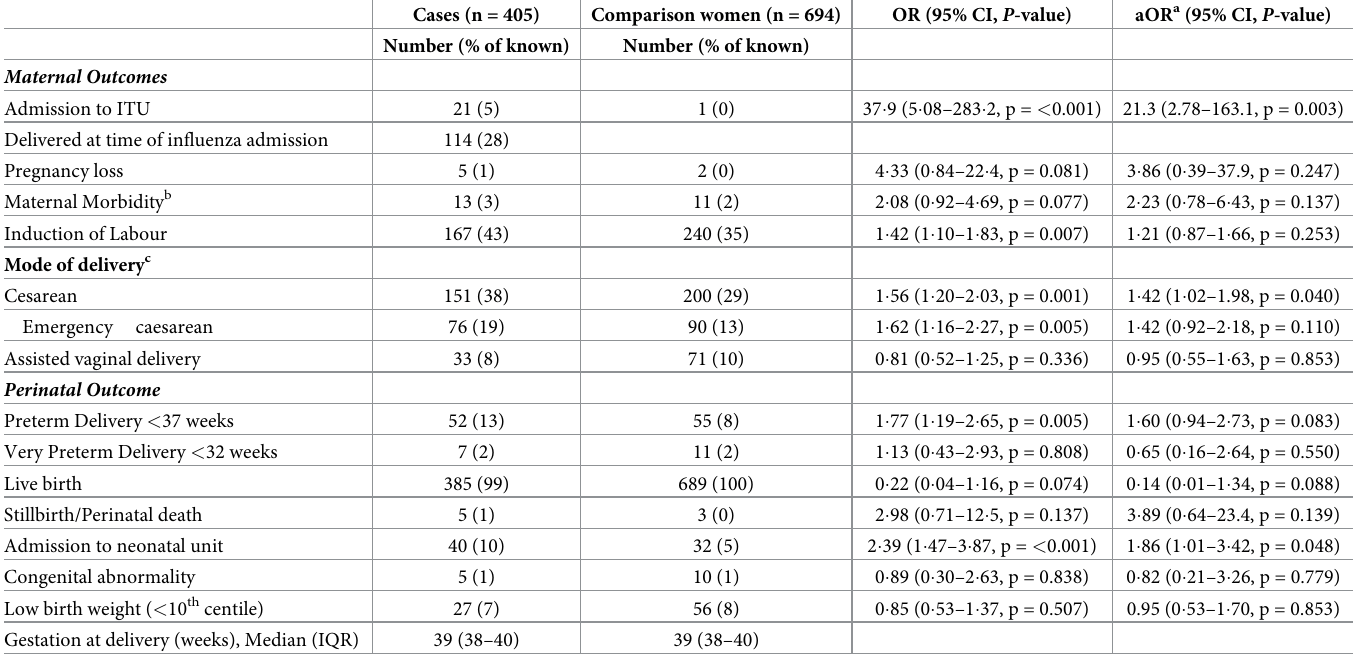
Table 2. Maternal and perinatal